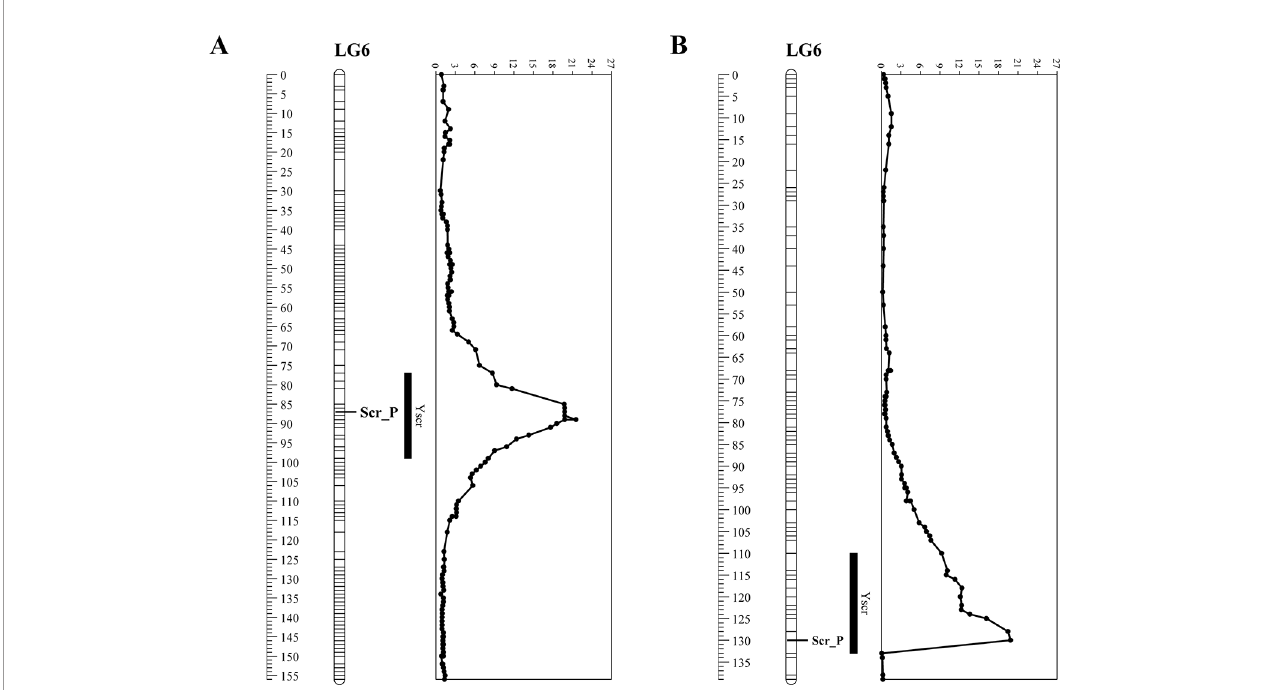
FIGURE 1 | Linkage analysis of phenotypic marker for fl esh color (Scr_P) and quantitative trait loci (QTL) pro fi ling of Y scr on linkage groups in two populations. (A) Analysis based on the F 2 population. (B) Analysis based on the BC 1 P 2 population.